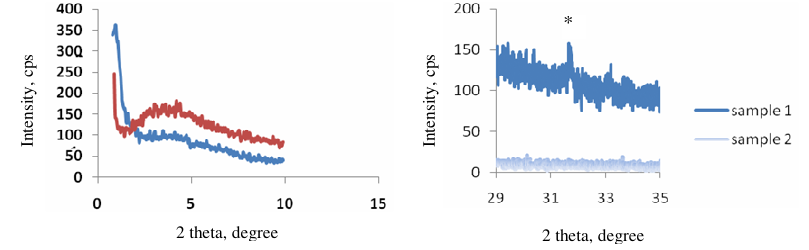
Figure 1 . XRD pattern of 1 & 2 at low angles